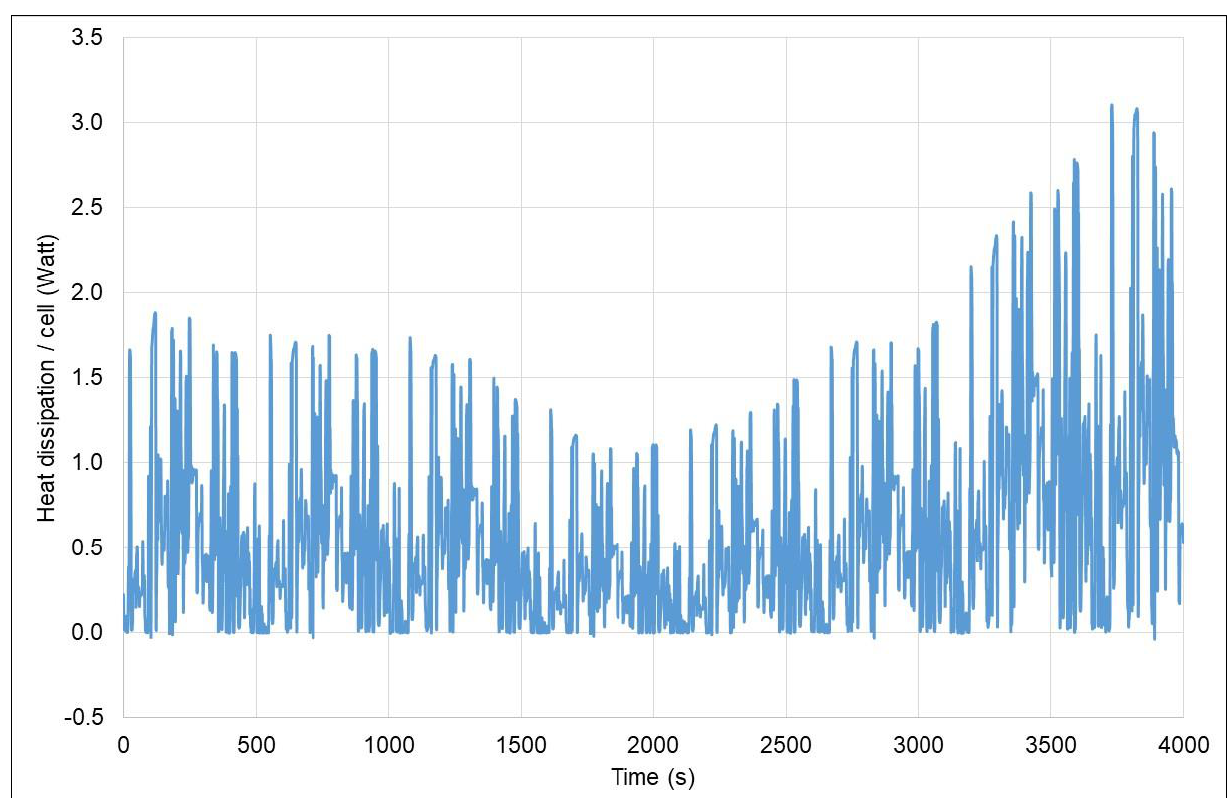
Figure 22. Thermal power released by a cell of the battery pack for the highway driving cycle.